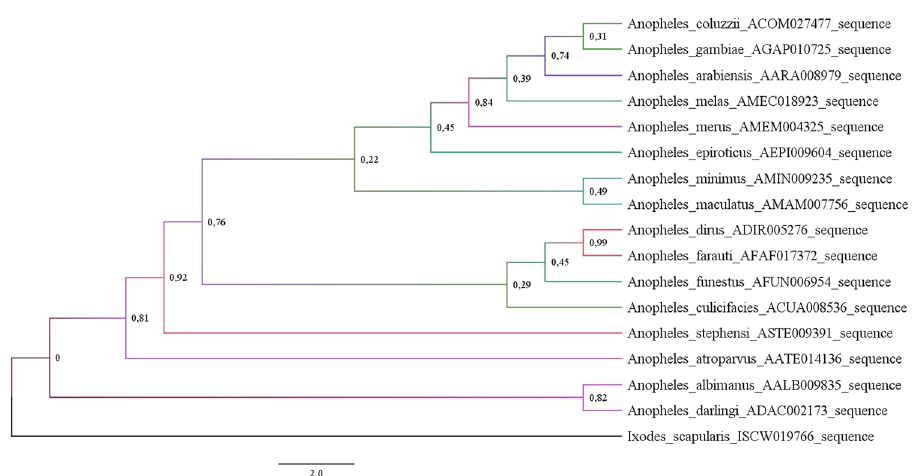
Figure 3. Prestin molecular phylogenetic analysis by Maximum Likelihood method. Using the Maximum Likelihood method based on the best fitted models (LG + G), the tree with the highest log likelihood ( − 1660.211) is shown. A Gamma distribution (G) was used to model evolutionary rate differences among sites (5 categories ( + G, parameter = 0.79). The tree is drawn to scale, with branch lengths measured in the number of substitutions per site. The analysis involved 17 amino acid sequences with respective VectorBase accession number: A. albimanus (AALB009835); A. arabiensis (AARA008979); A. atroparvus (AATE014136); A. coluzzii (ACOM027477); A. culicifacies (ACUA008536); A. darlingi (ADAC002173); A. dirus (ADIR005276); A. epiroticus (AEPI009604); A. farauti (AFAF017372); A. funestus (AFUN006954); A. gambiae (AGAP010725); A. maculatus (AMAM007756); A. melas (AMEC018923); A. merus (AMEM004325); A. minimus (AMIN009235); A. stephensi (ASTE009391) and Ixodes scapularis (ISCW019766) (outgroup). All positions containing gaps and missing data were eliminated and bootstrap values for internal branches are